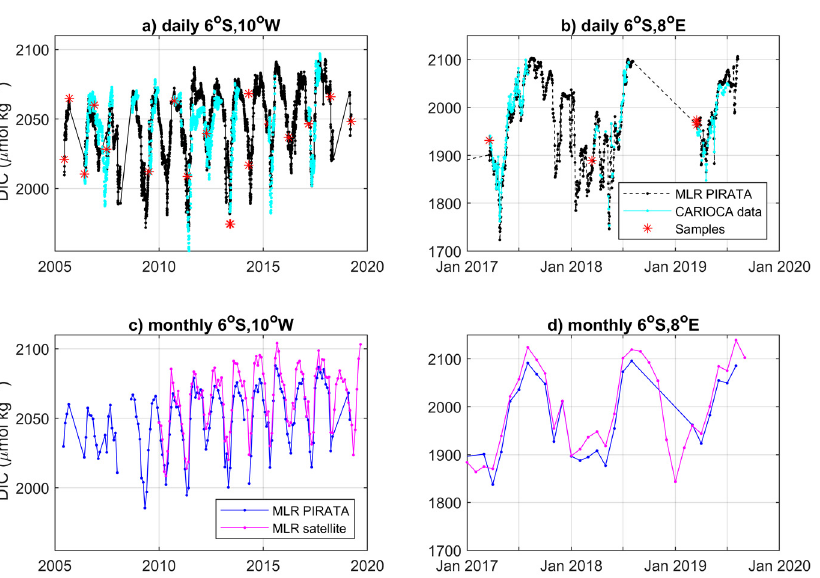
Figure 8. ( a ) Daily DIC determined from the multiple linear regressions (MLR) using SST and SSS recorded at the 6° S, 10° W mooring since 2006 (in black) and calculated from measured seawater fCO 2 and TA–SSS (in cyan) at 6° S, 10° W The DIC samples are in red. ( b ) as in ( a ) for the mooring at 6° S, 8° E from 2017 to 2019. ( c ) Monthly DIC calculated with the MLR using SST and SSS recorded at the mooring (in black) and using satellite SST and SSS (in blue) collocated at 6° S, 10° W. ( d ) same as in ( c ) for the mooring at 6° S, 8° E from 2017 to 2019.